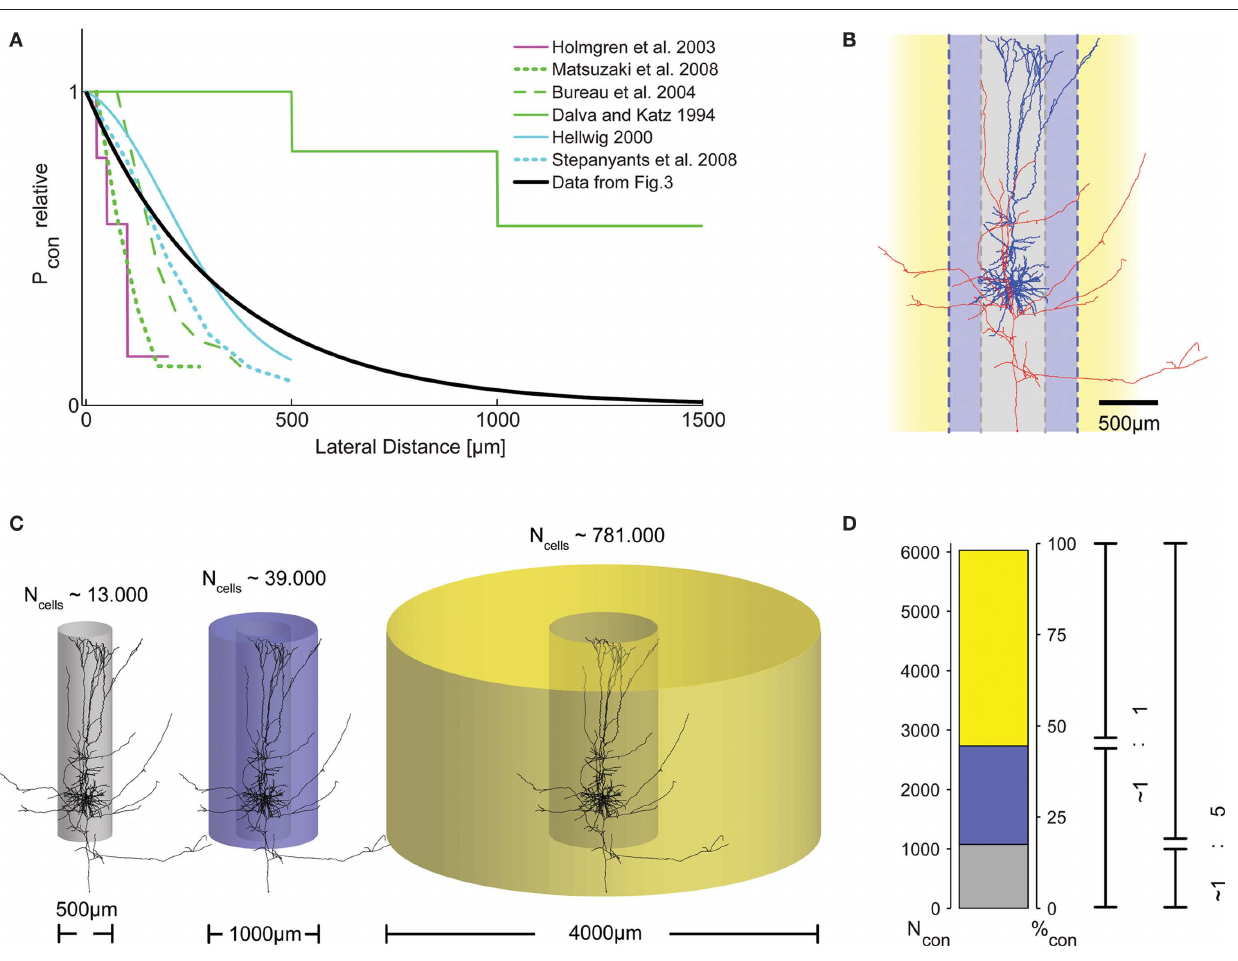
increase of the volume covered by cylinders with increasing radius. This implies that the number of connected cells does not necessarily decrease with increasing distance, even if connection probability drops substantially. (D) To emphasize the consequences of the described distance dependence of P con con for the total number of actually connected presynaptic cells within a certain distance, we calculated the numbers of these synaptically connected cells for the three different ranges depicted in (C) . For all volumes, we used our exponential decay model with λ = 330 μm and P = 0.135 and, again, assumed 0 a thickness of cortical gray matter of 1.3 mm. Surprisingly, even with a strong decay in P diameter [cf. extent of the bar in (D) does not account for